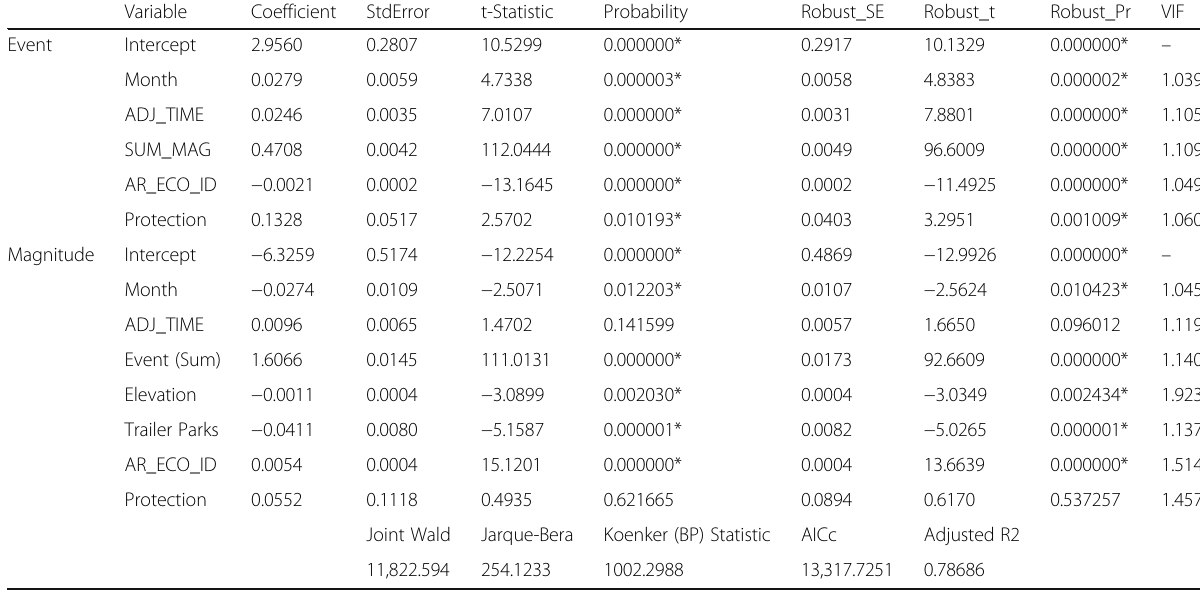
Table 1 Ordinary Least Squares results for tornadoes